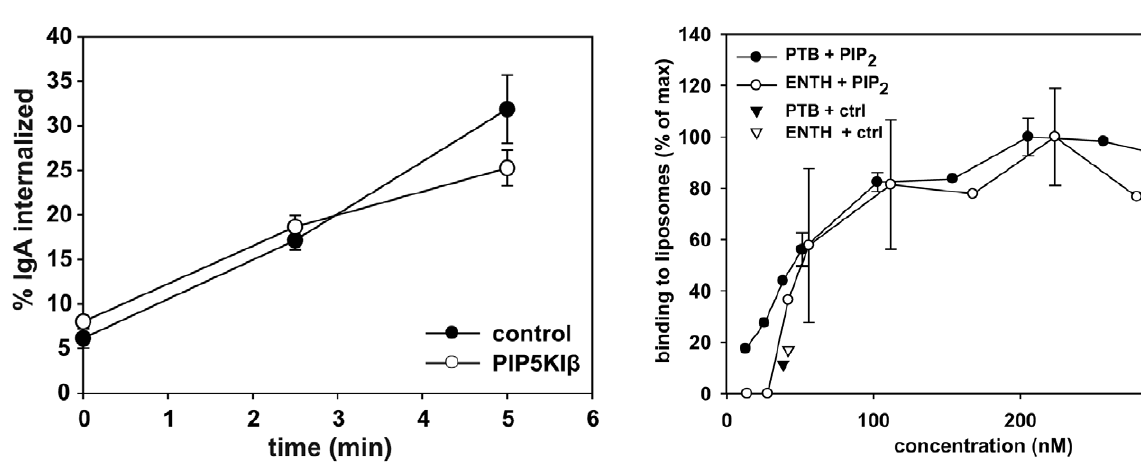
Figure 6. Endocytosis in non-polarized cells is unaffected by PIP5KI b . (A) Internalization kinetics of 125 I-IgA were measured in non- polarized cells co-infected with adenovirus encoding the polymeric immunoglobulin receptor and either control or PIP5KI b adenovirus. The graph shows the percent of internalized 125 I-IgA over a five min time course. The mean + / 2 range from one experiment performed in duplicate is shown. Similar results were obtained in three independent experiments.